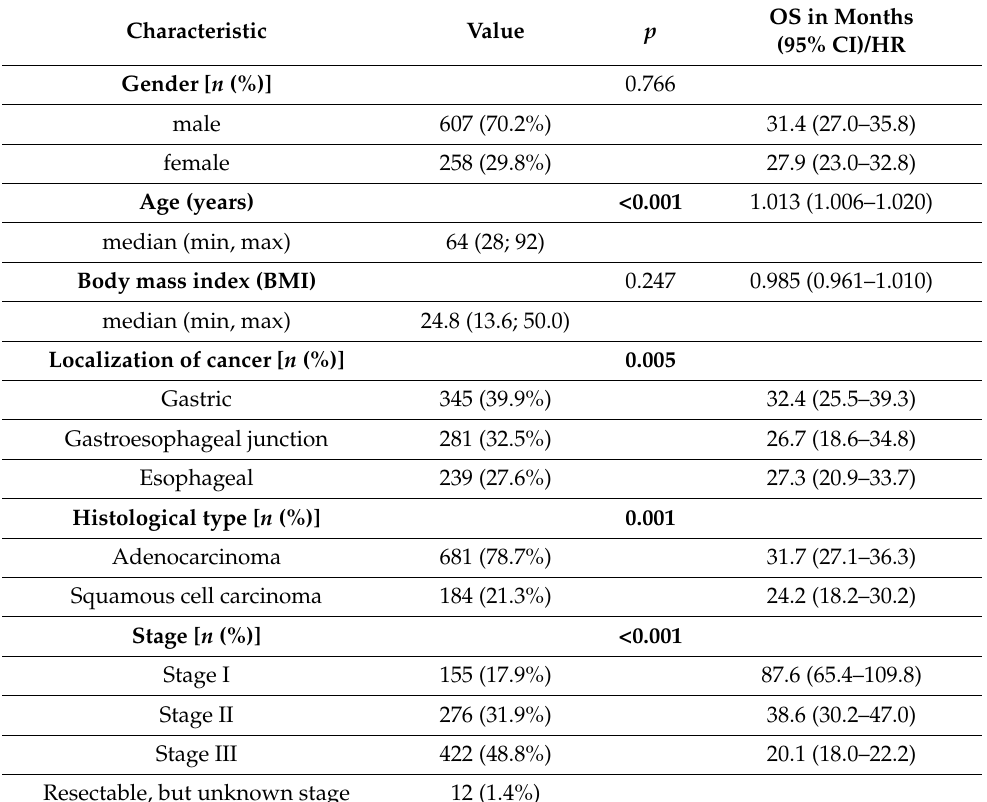
Table 1. Patient demographics and cancer characteristics and their correlation with survival. Abbre- viations: OS—overall survival, CI—confidential interval, HR—hazard